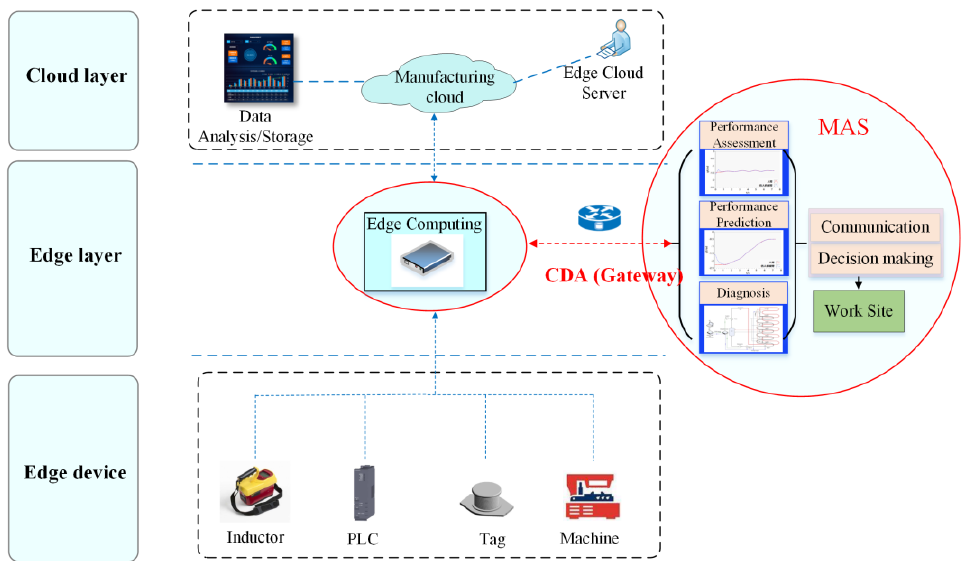
Figure 2. Cooperation framework of the system layer.